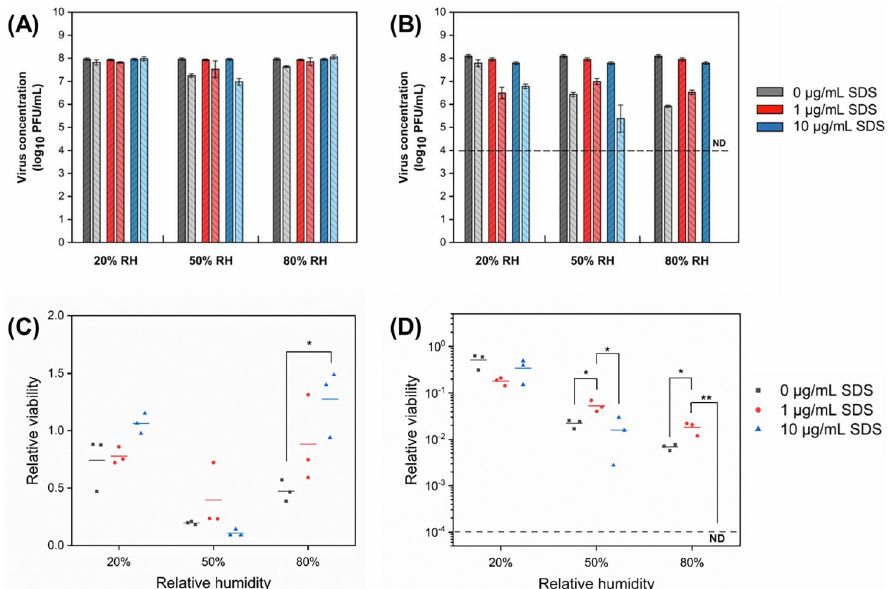
The relative viability of MS2 in droplets with different surfactant concentrations is shown in Fig 5A and 5C. MS2 generally survived better when SDS was present in droplets, and relative